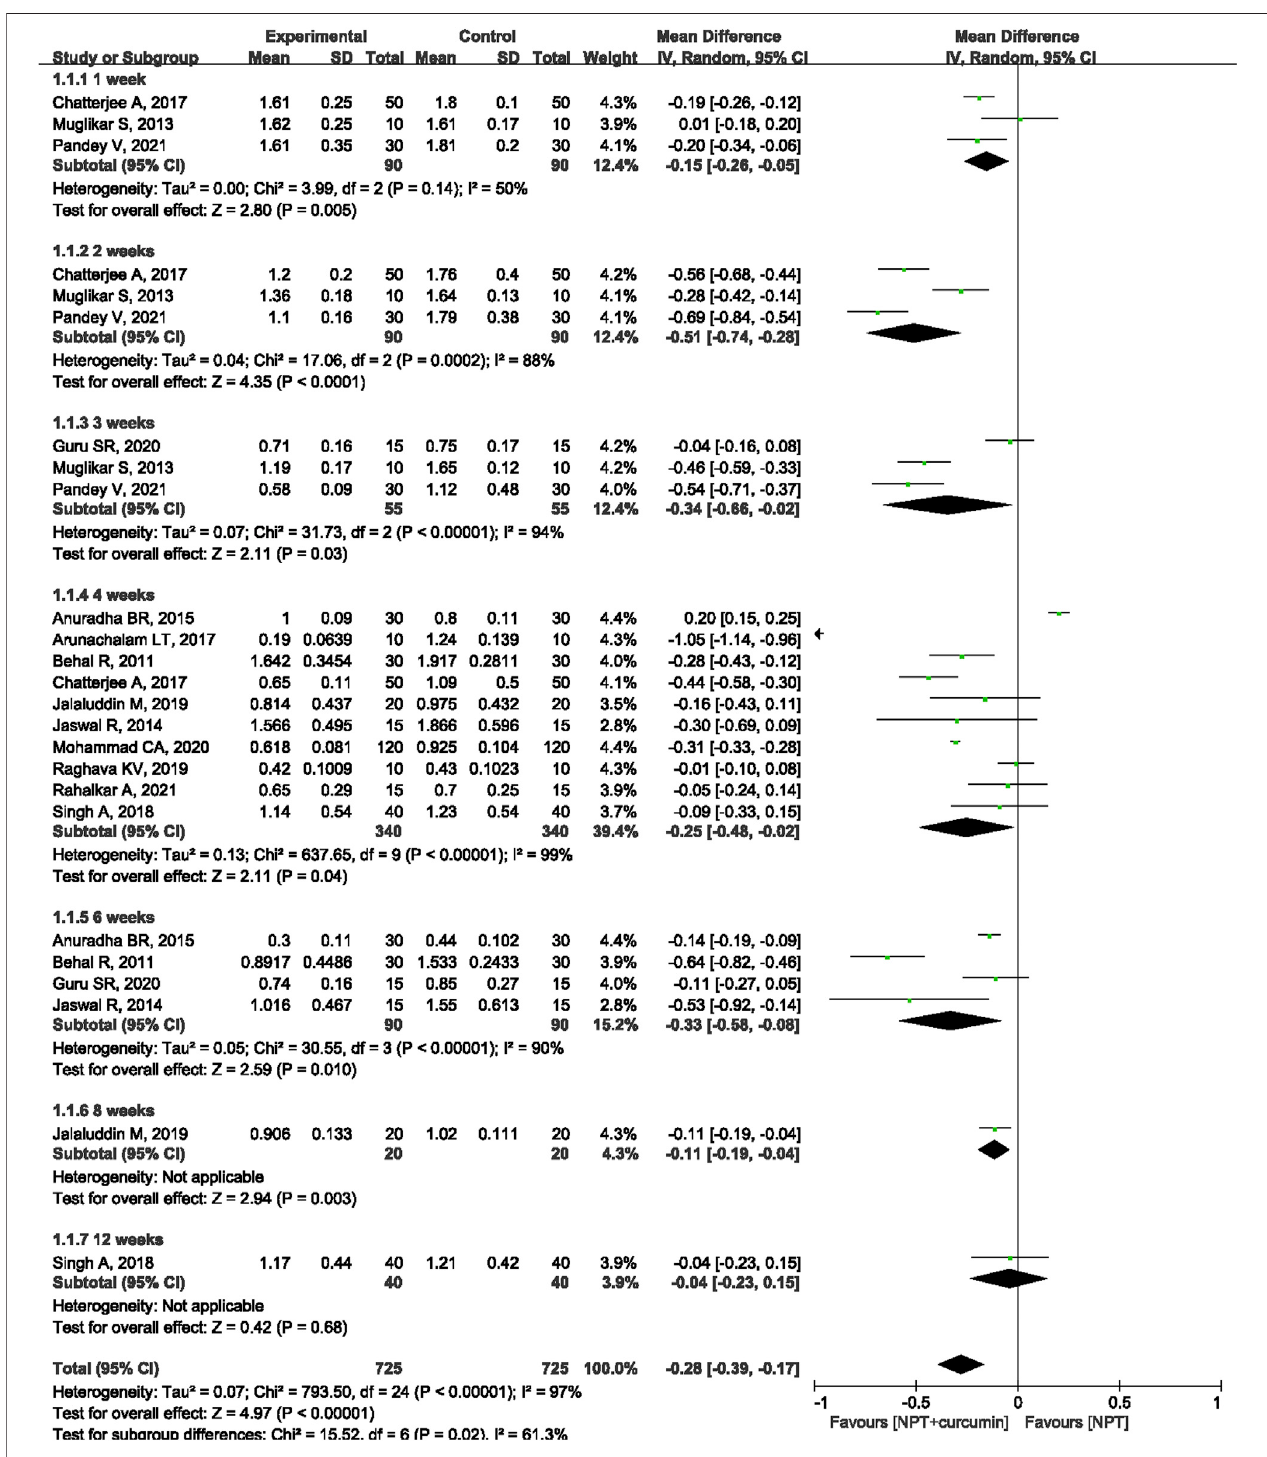
FIGURE 4 | Forest plot of the effects of curcumin + NPT versus NPT on GI.